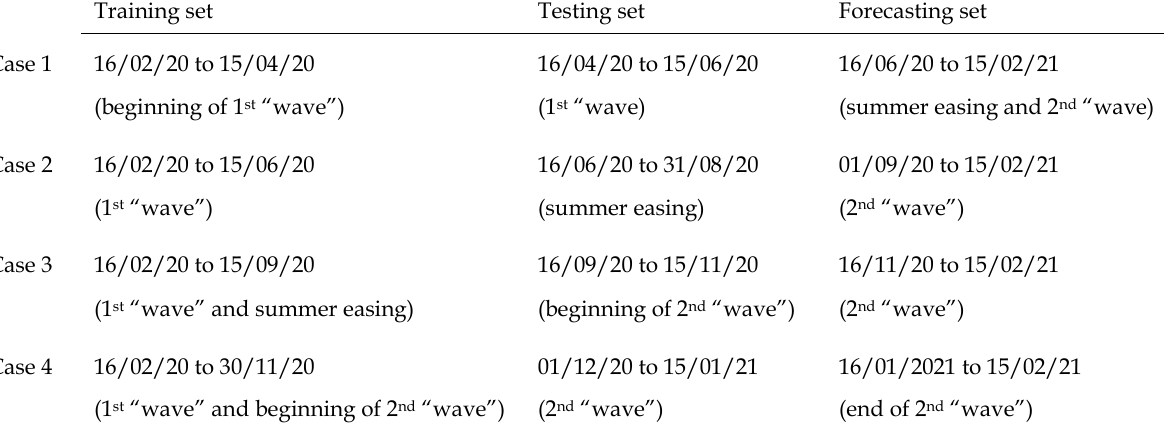
Table 1. An overview of training, testing and forecasting